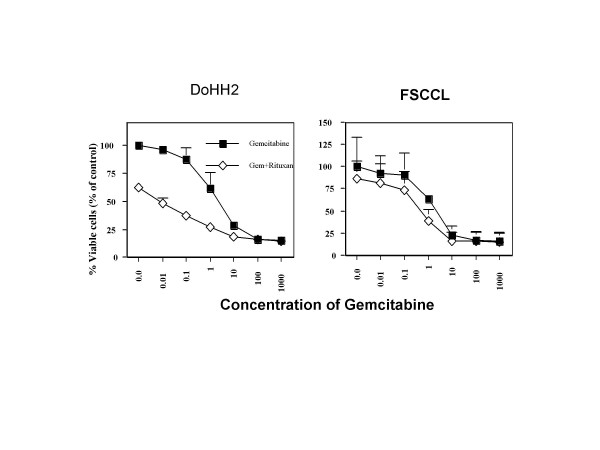
Cytotoxicity of rituximab and gemcitabine. WSU-FSCCL or DoHH2 cells incubated with varying concentrations of gemcitabine, and 4 hr later ± 20 μg/ml rituximab. Cytotoxicity is expressed as percentage of untreated control cells at 72 hr.